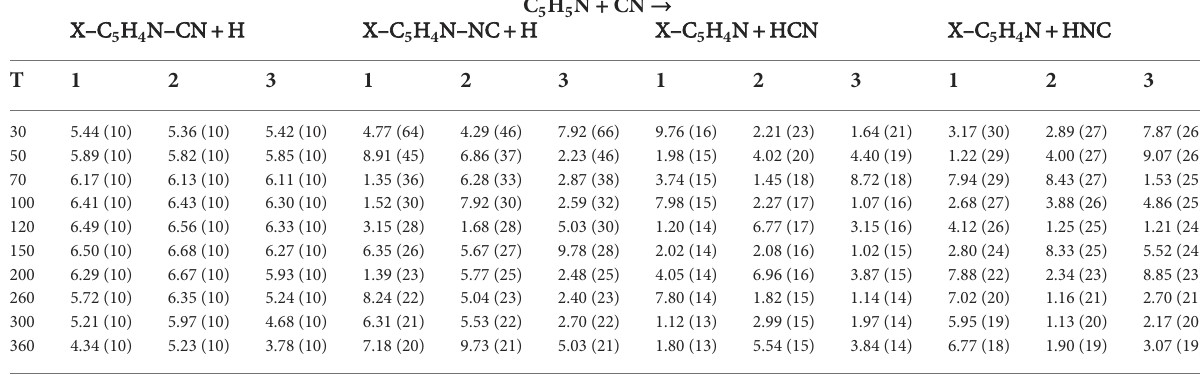
TABLE 3 Numericalvaluesoftherateconstantsobtainedinthepresentworkforthedifferentcarbonandhydrogenpositionsinthe(30–360)Krange.The notationA(B)represents A ×10 − B cm 3 s − 1 .